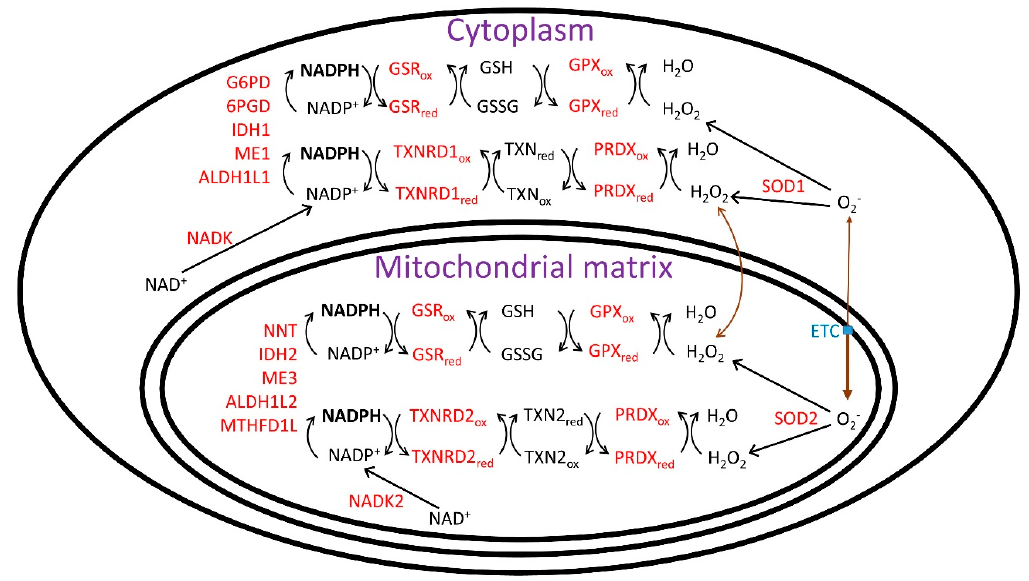
Figure 1. Cytoplasmic and mitochondrial reduced nicotinamide adenine dinucleotide phosphate (NADPH)-linked redox systems. NADK: nicotinamide adenine dinucleotide (NAD + ) kinase; ETC: electron transport chain; GSR: glutathione reductase; GSH: reduced glutathione; GSSG: oxidized